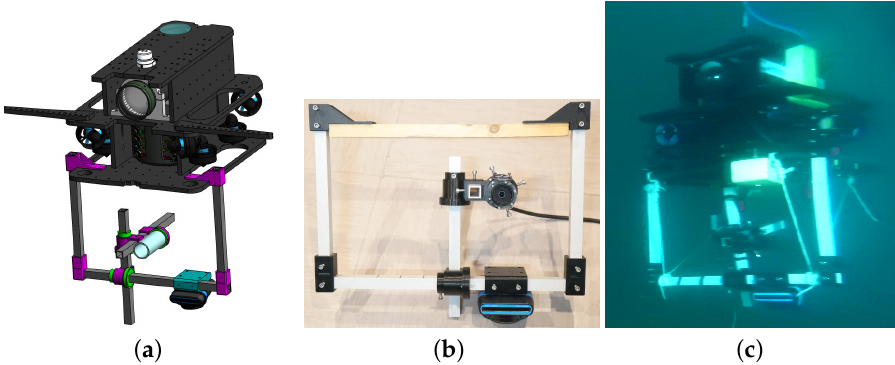
Figure 11. ( a ) The CAD model of the Basile ROV and its frame, allowing to modify the relative positions of the camera and the sonar. ( b ) The mechanical frame with the optical camera and the sonar. ( c ) The frame attached to the Basile ROV during a dive in Marseille.